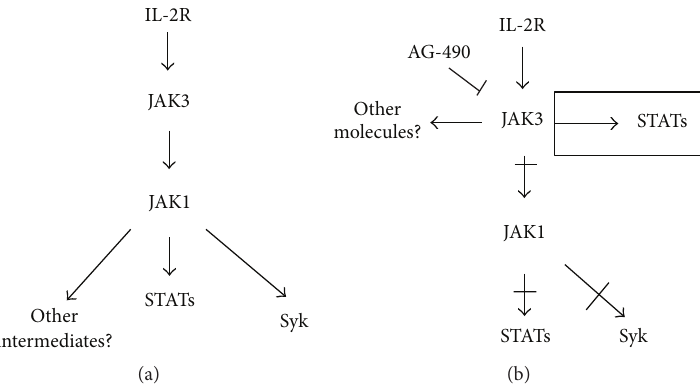
Figure 1: Model of the IL-2R signalling pathway. Zhou et al. [8] propose the model as follows: (a) the first molecule activated is JAK3 and the next molecule in the pathway is JAK1; Syk functions as a downstream element of the JAKs in IL-2 signalling. JAK3 may regulate Syk and STAT activity indirectly via JAK1. Our model proposed for cervical cancer cells is shown in (b). The crossed arrows represent the steps that are not performed in cervical cancer cells but appear in the normal cell model. The rectangle shows a step that is not found in the normal cell